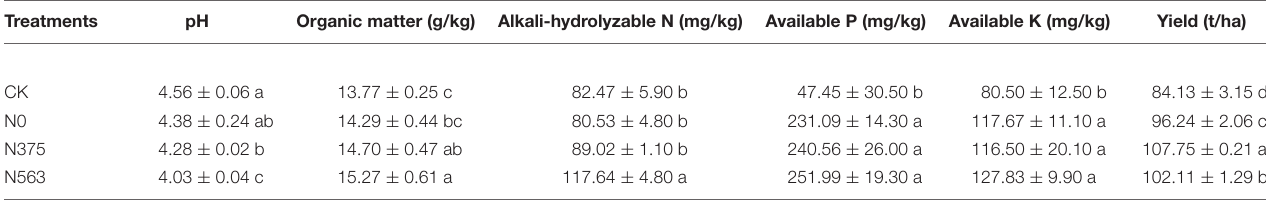
TABLE 1 | Physiochemical properties and crop yields in all the treatments. Treatments